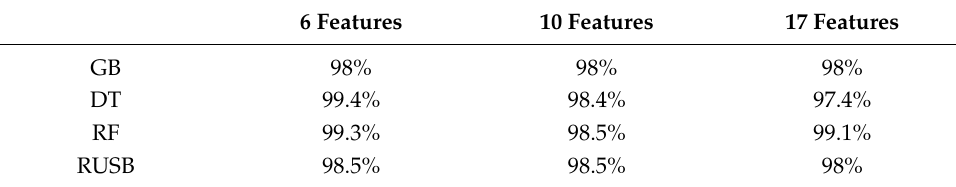
Table 14. Accuracy of the ML algorithms to predict the outcome Mortality. SMOTE was used.